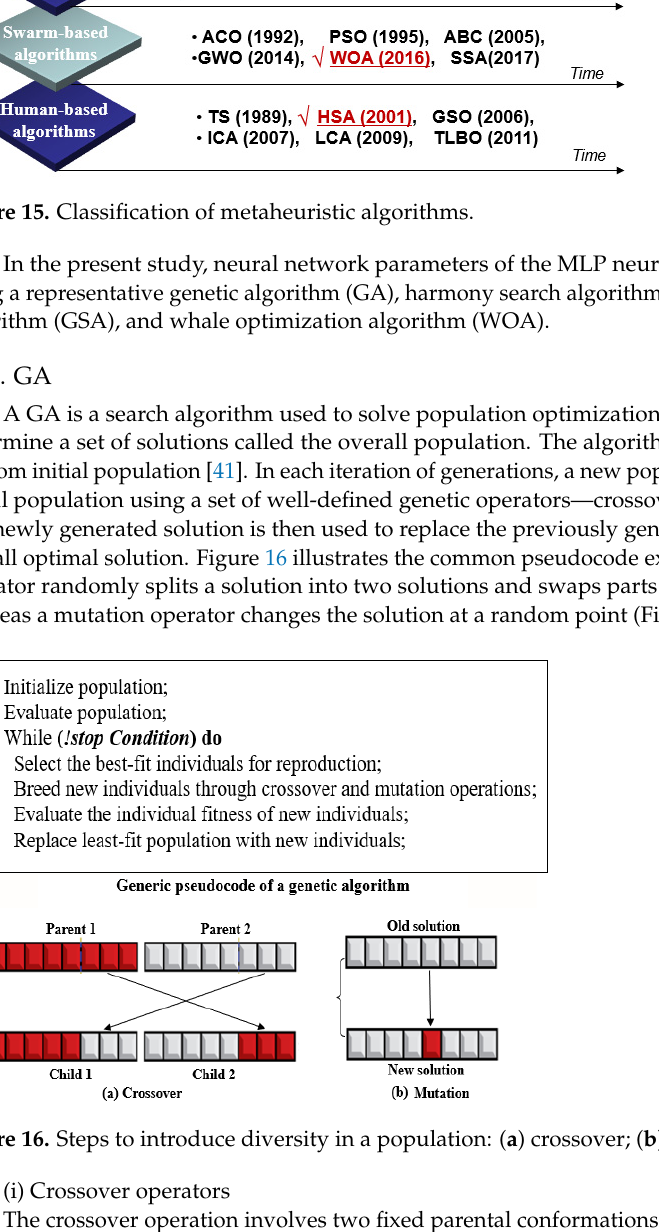
Figure 16. Steps to introduce diversity in a population: (a) crossover; (b) mutation.